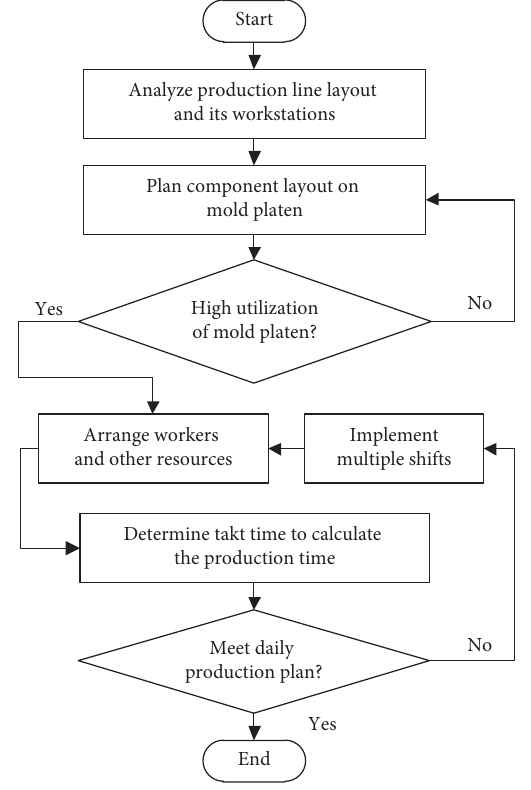
Figure 2: Framework for the existing production planning